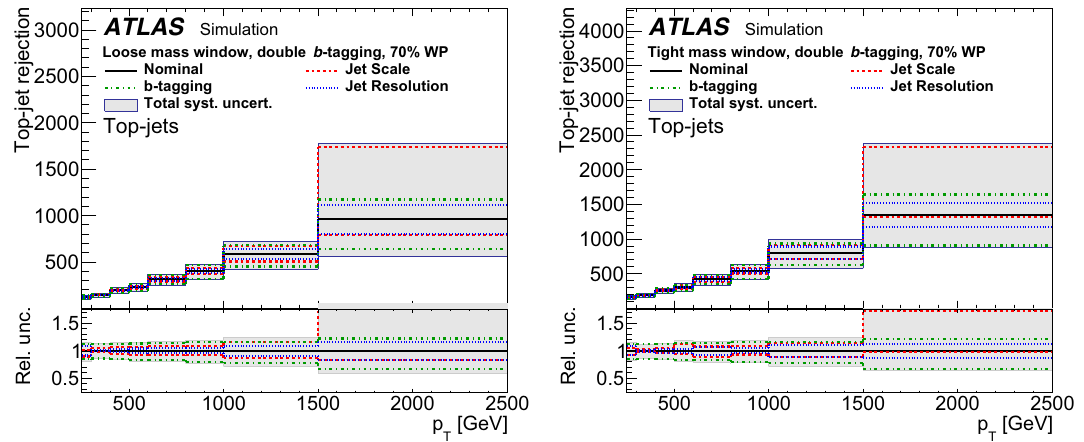
Fig. 9 Rejection of the top-jet background as a function of the Higgs- jet p T for the loose (left) and tight (right) mass window requirements, in combination with the 70% double- b -tagging working point. The nomi- nal curves correspond to the requirement on the MV2c10 discriminant described in Sect. 6.2. Systematic uncertainties defined in Sect. 5 as